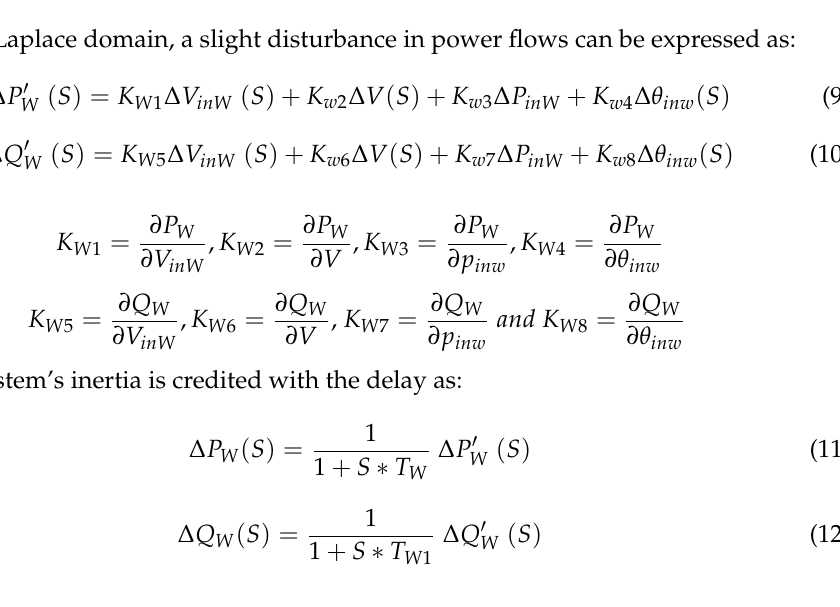
Figure 2. SLD of Figure 2. SLD of WECS.